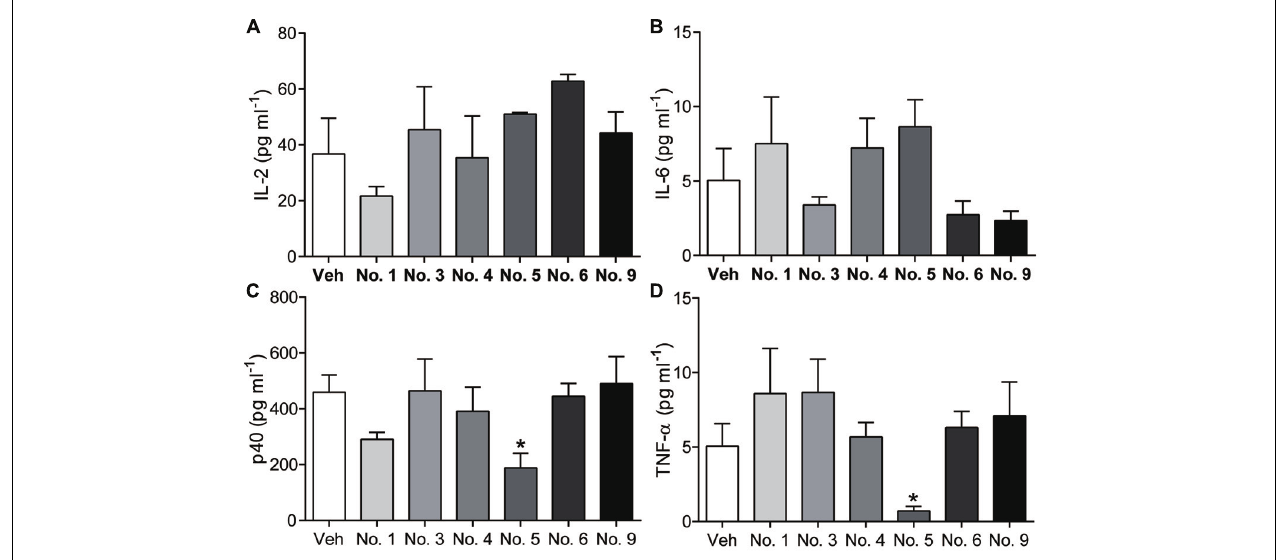
FIGURE 4 | Cytokine levels in sera of mice treated by extracts of endophytic actinobacteria. IL-2 (A) , IL-6 (B) , IL-12/IL-23 p40 (C) , and TNF- α (D) levels in serum were measured by ELISA. No.1-YFT113, No.3-YXN111, No.4-YXN112, No.5-YXT131, No.6-YKFG1221, No.9-YKFT1130. Data are means ± SD ( n = 5), ∗ p < 0.05 vs.